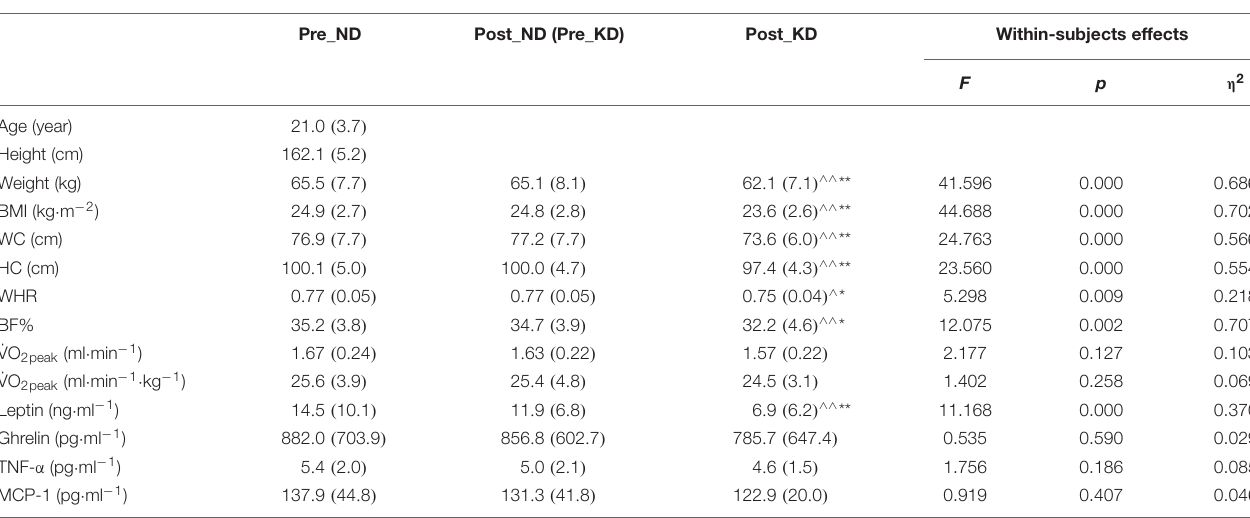
FIGURE 2 | Daily energy intake (A) , proportions of carbohydrate (B) , protein (C) , and fat (D) intakes during normal diet (ND) and ketogenic diet (KD). Compared to week 1 of ND at a p < 0.01; compared to week 2 of ND at b p < 0.01; compared to week 3 of ND at c p < 0.01; compared to week 4 of ND at d p < 0.01. TABLE 1 | Main outcome variables before and after ND and